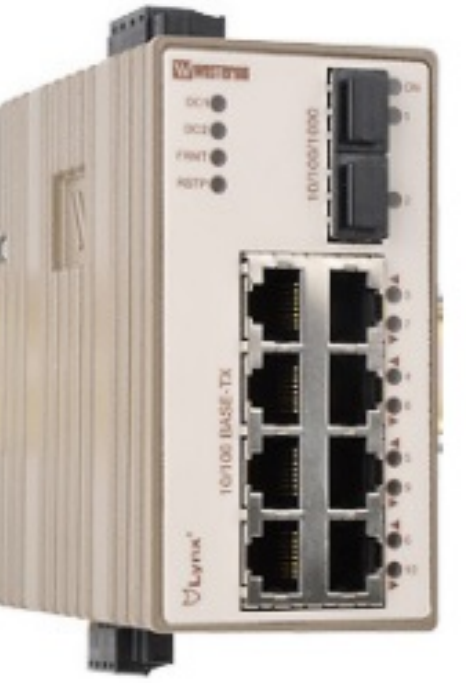
Figure 2. An example Westermo data switch.